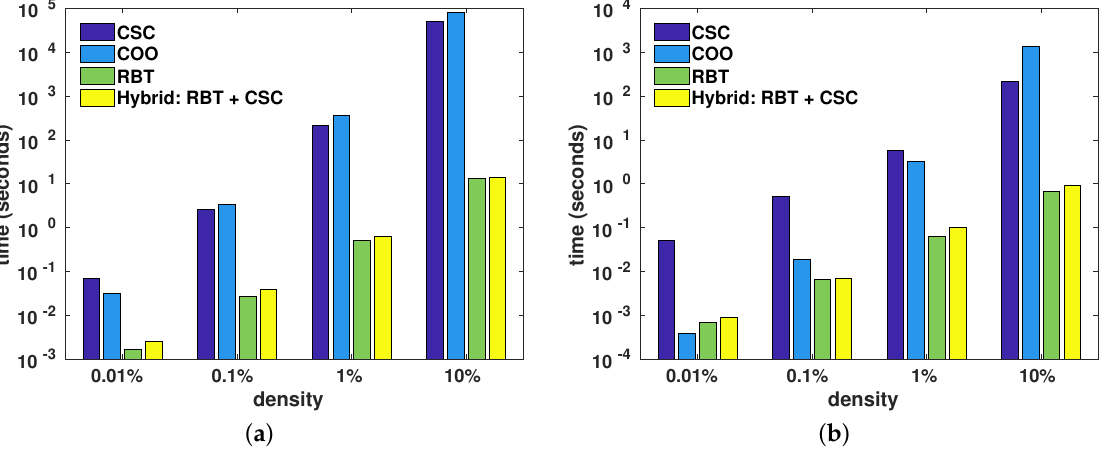
Figure 6. Wall-clock time taken to insert elements into a 10,000 × 10,000 sparse matrix to achieve various densities of non-zero elements. In ( a ), the elements are inserted at random locations in random order. In ( b ), the elements are inserted in a quasi-ordered fashion, where each new inserted element is at a random location that is past the previously inserted element, using column-major